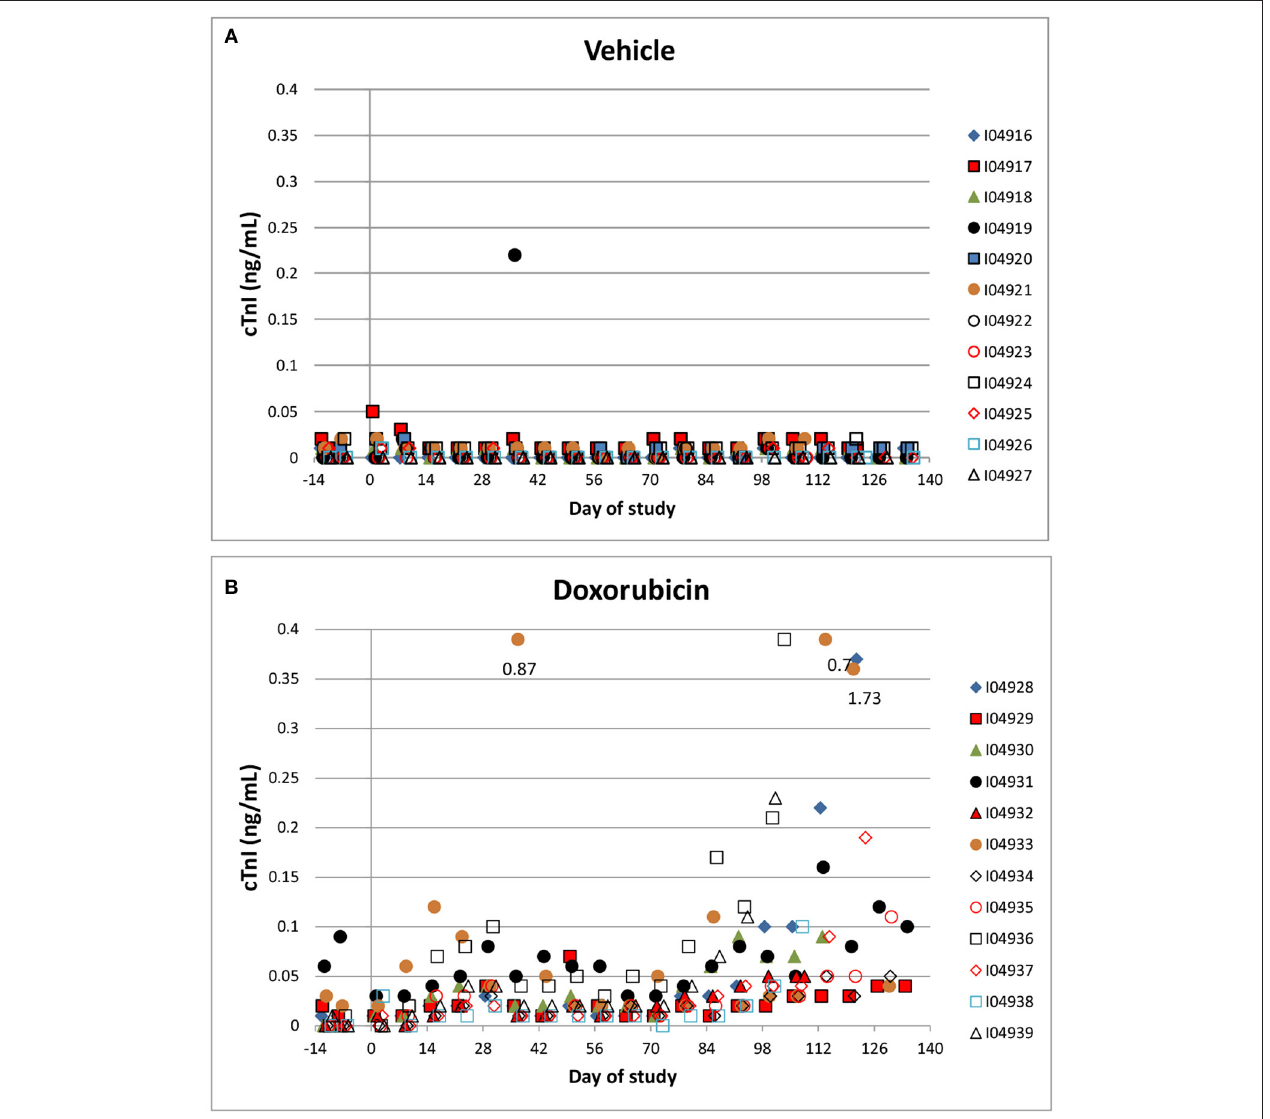
FIGURE 6 | Cardiac Troponin. Changes in individual animal cTnI in control (A) a treated (B) animals over the course of the study. Filled markers denote animals equipped with LVP